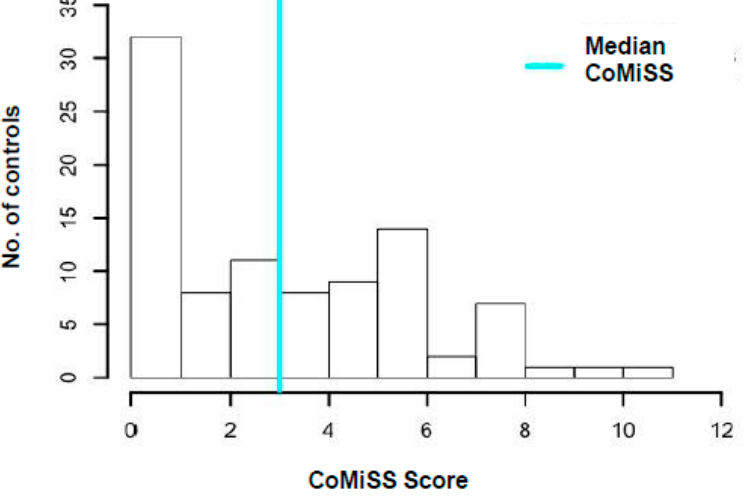
Figure 2. Distribution of the CoMiSS TM score in controls. T0: Time 0 (first visit). The symptoms included in CoMiSS TM and differences between cases and controls at T0 are reported in Table 1.